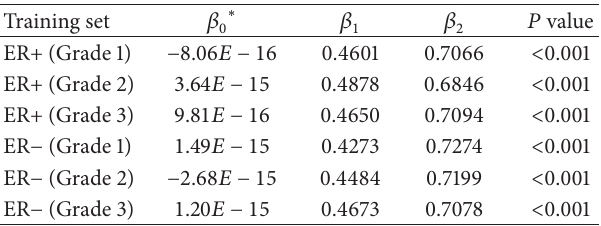
Table 3: Regression coefficients of 𝜇 ( 𝛽 1 ) and 𝜎 ( 𝛽 2 ) in each of the six training sets,